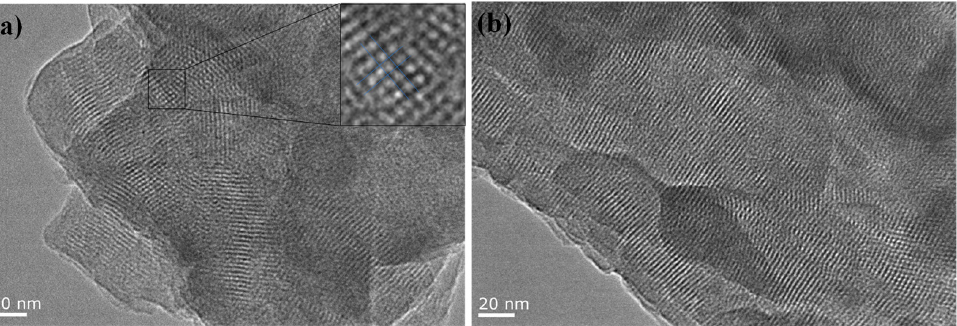
Figure 4. FE-TEM images of ( a ) IM4F-Py-COF and ( b ) BMIM4F-Py-COF. The inset in Figure 4a shows an enlarged image.